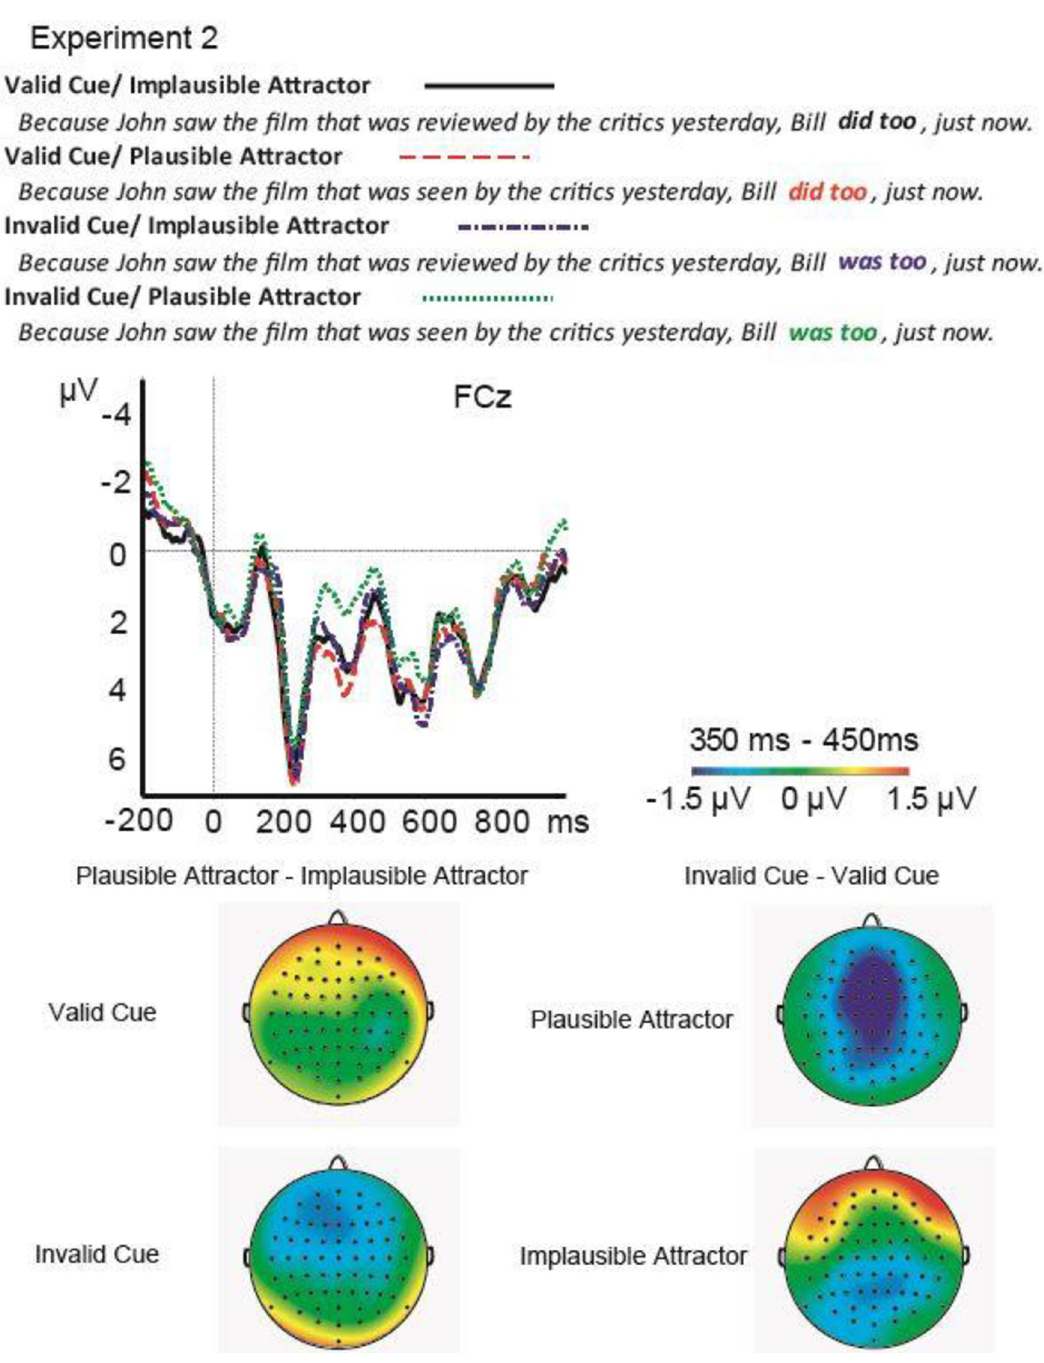
Fig 3. Results from Experiment 2. ERPs elicited by each condition at FCz and Pz, and the scalp distribution of the effect of Cue Validity for the Implausible and the Plausible Attractor conditions in the 300–500 ms time window befitting the N400 modulation. The pattern of ERPs on FCz is representative of the effects across frontal channels, while the pattern on Pz is representative of posterior channels.